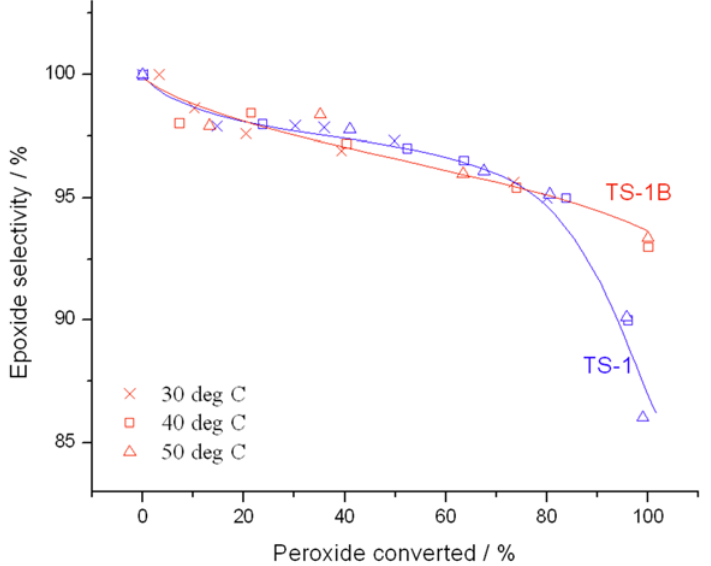
Figure 4. Comparison of selectivity as a function of conversion for (blue) TS-1 and (red) TS-1B. Reaction conditions: [allyl alcohol] = 0.5 M, [H 2 O 2 ] = 0.25 M, mass of catalyst = 50